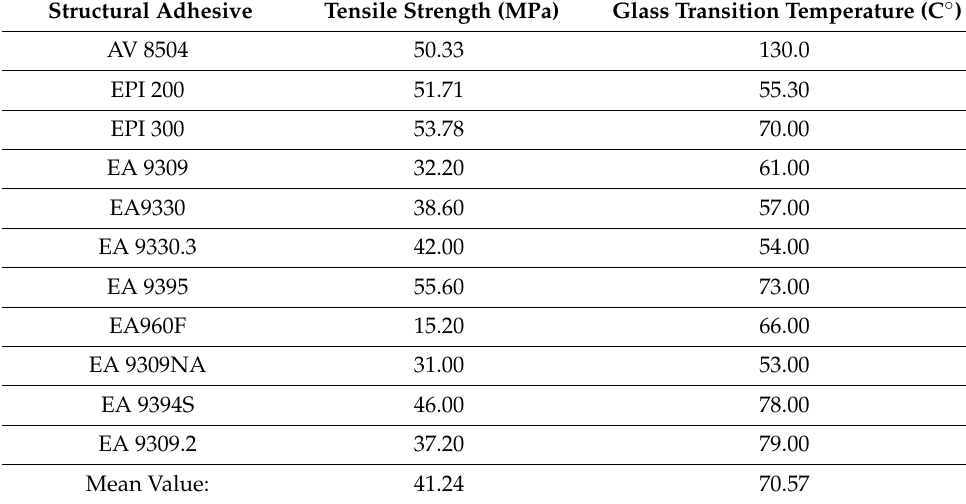
Table 8. Tensile strength and glass transition temperature of structural adhesives.